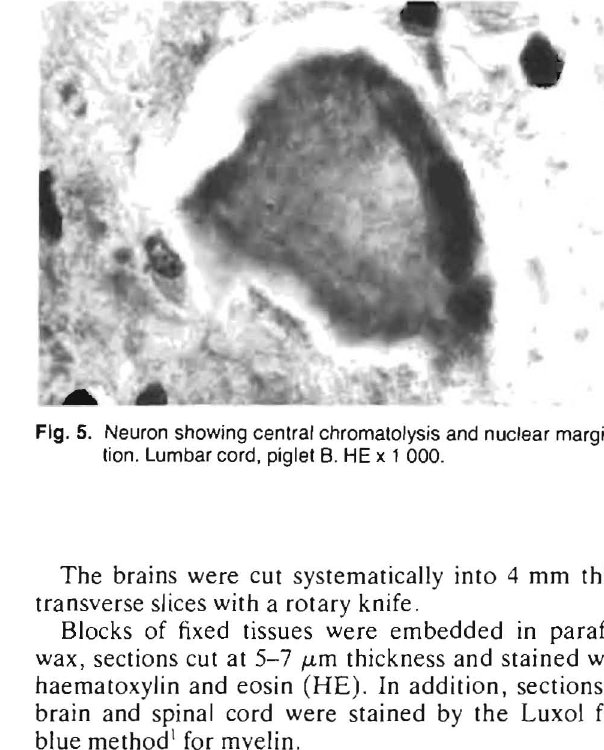
always to the same side. In A, deflection was always to the right and, in B (See Fig. 2) and C, always to the left.